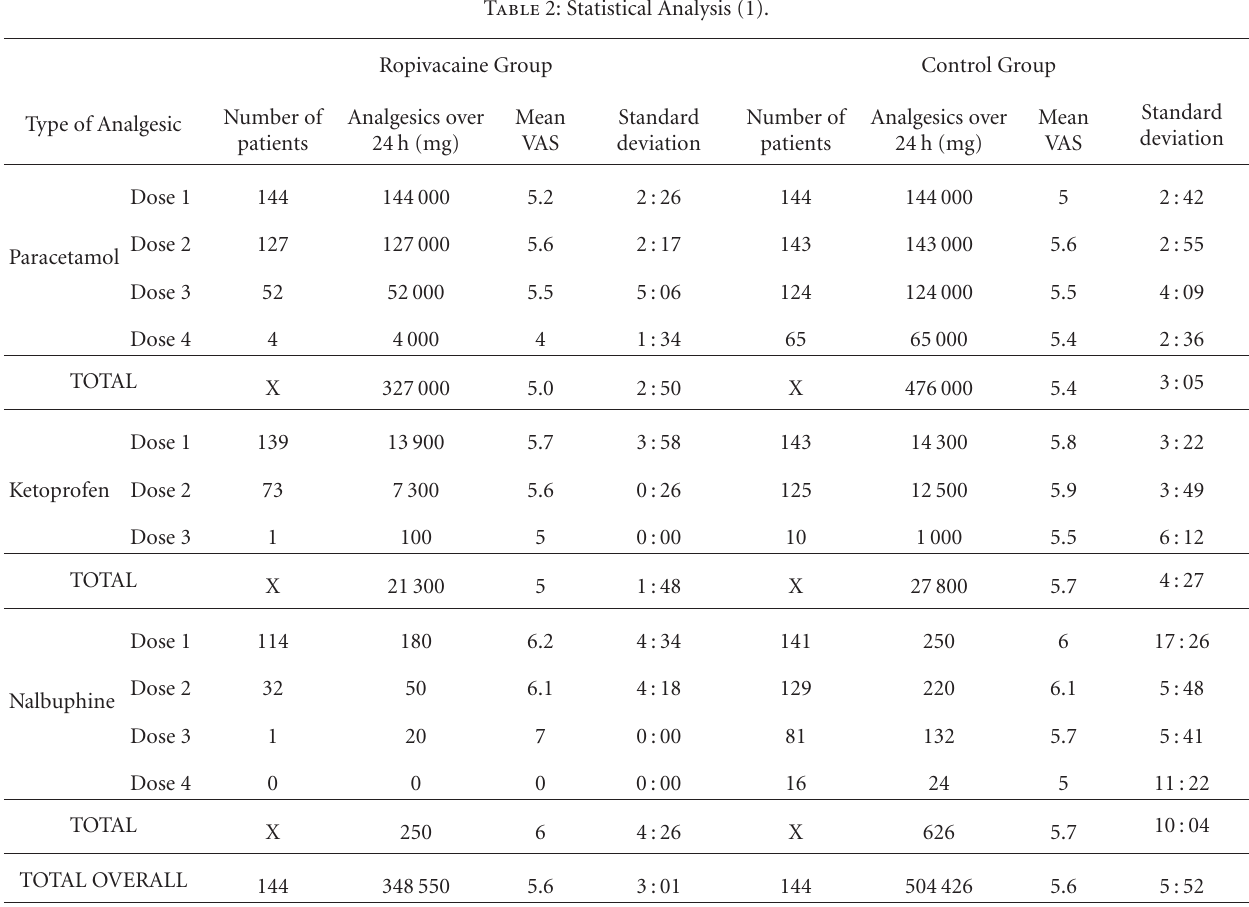
Table 2: Statistical Analysis (1).